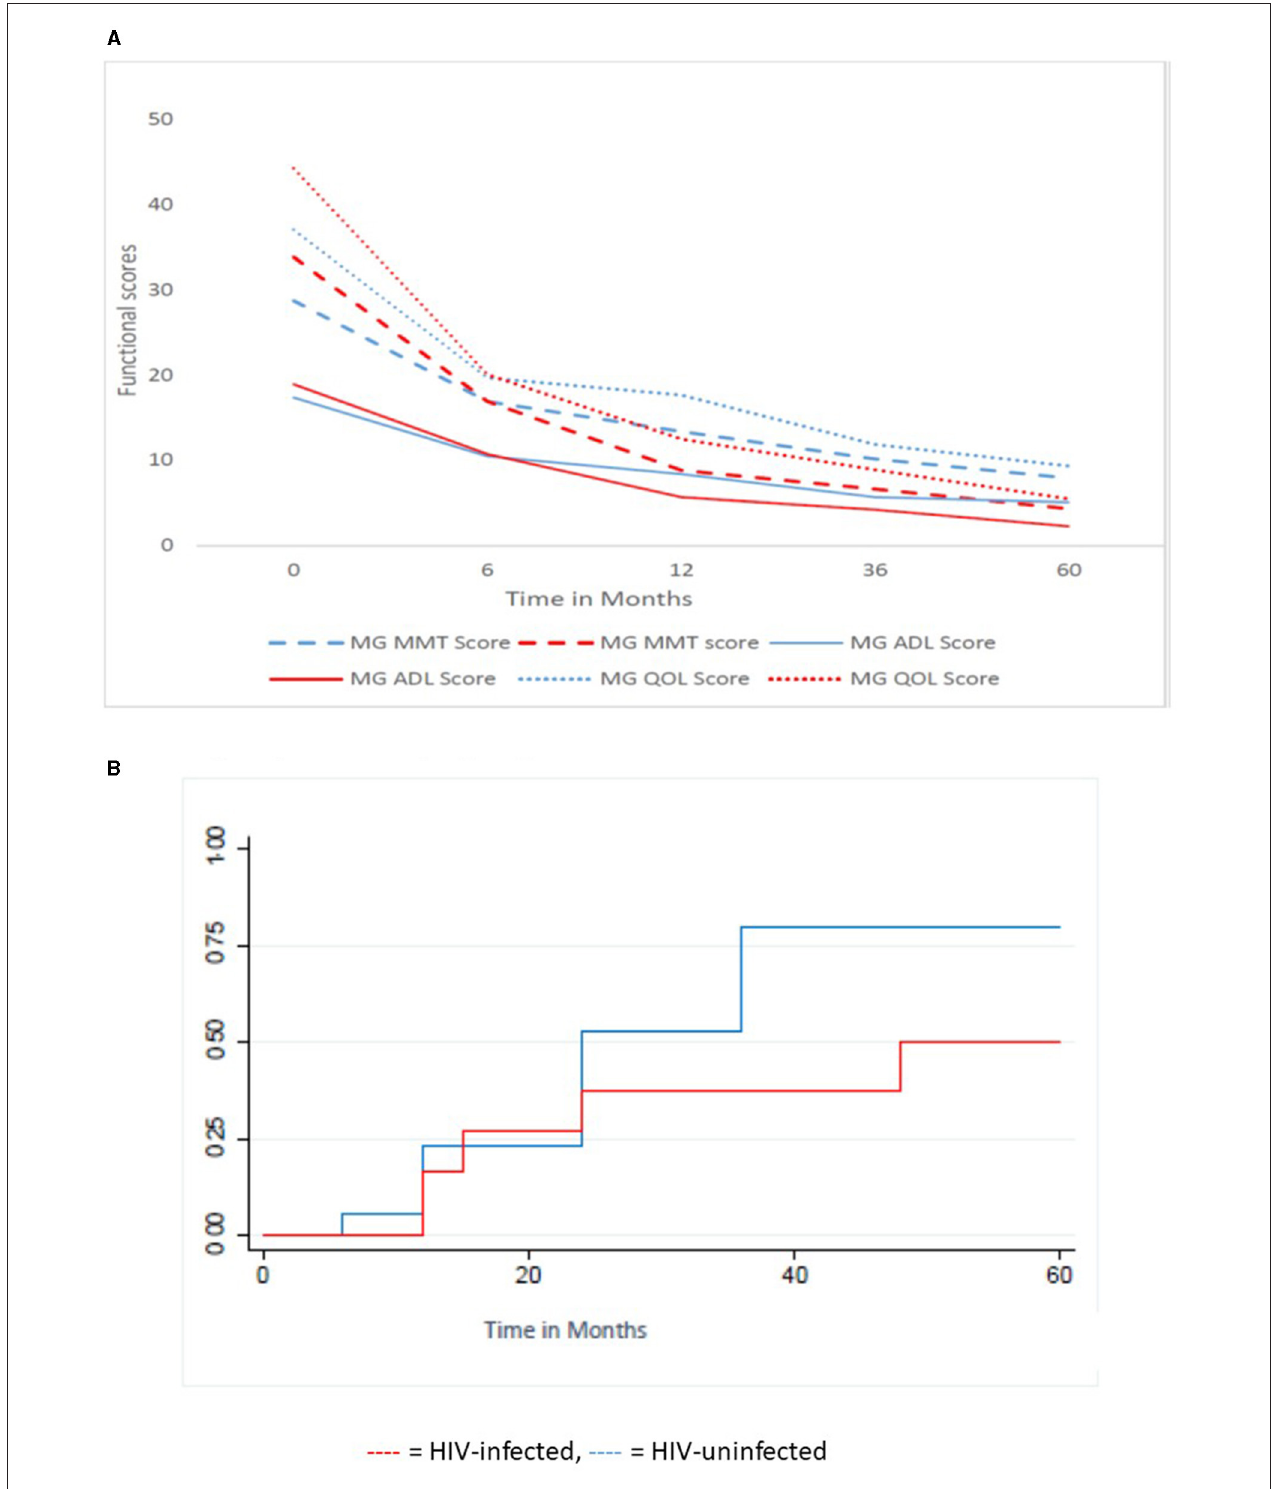
FIGURE 3 | Functional scores and Kaplan Meier time to remission for the HIV-infected (13 patients) and HIV-uninfected (17 patients) cohort receiving PLEX/IVIG and IVI cyclophosphamide. (A) Functional scores over time, (B) Kaplan Meier Curve of Survivor function. MMT, Manual Muscle Testing; ADL, Activity of daily living; QOL, Quality of life; , HIV-infected; ,